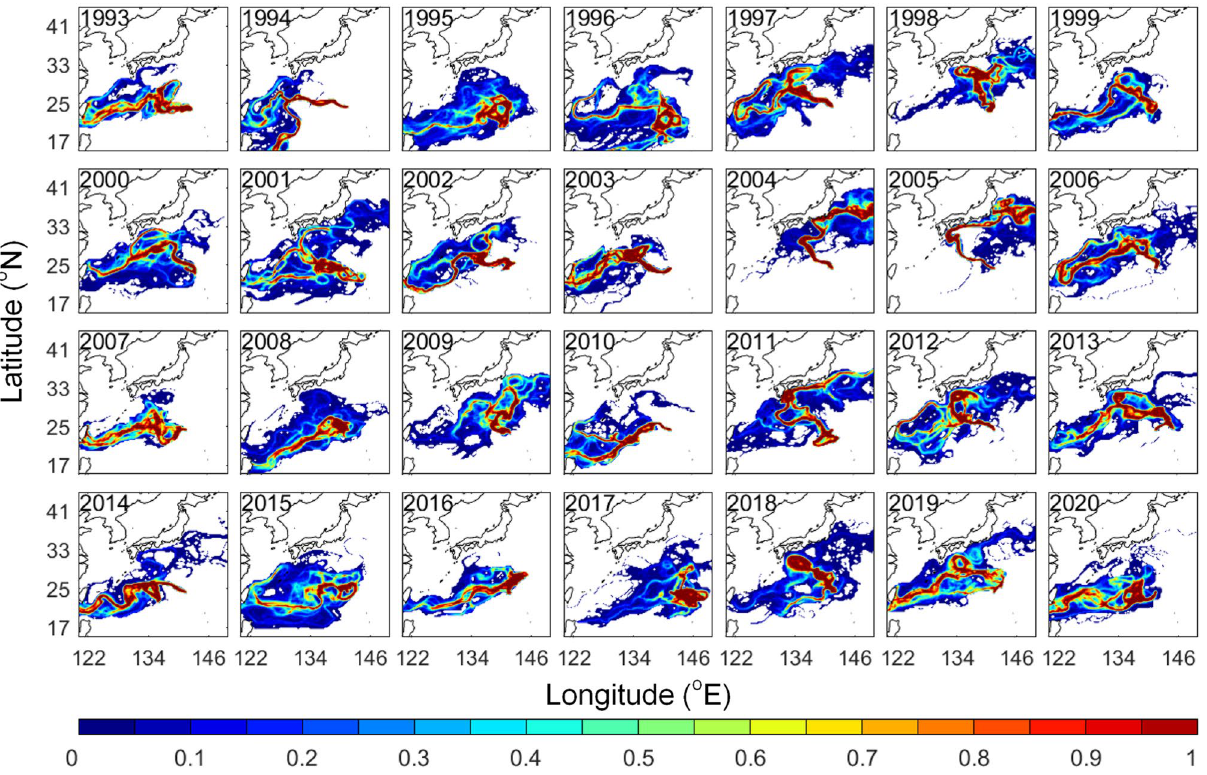
Figure 5. Normalized visitation frequency from 1993 to 2020 based on 2% windage. Figure is created using MATLAB R2011b (http:// www. mathw orks. com/).